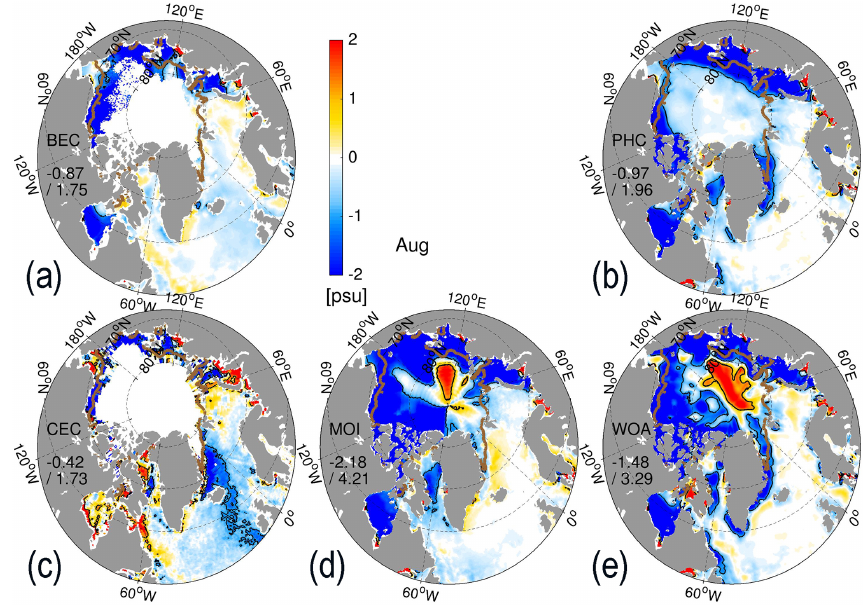
Figure 4. Deviations of monthly SSS (unit: psu) in August for (a) BEC, (b) PHC, (c) CEC, (d) MOB, and (e) WOA relative to TP4. The thick brown line represents sea-ice edge (15% concentration from TP4), the black lines represent ± 1psu.